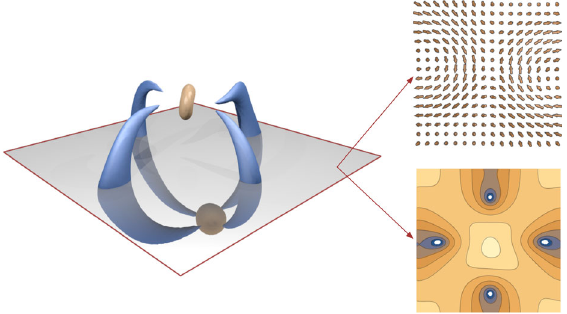
FIG. 4. Umbilic lines in a toron. (a) Simulation results showing point defects and characteristic umbilic loop in a toron. The umbilic loop is transverse and has zero self-linking number. The point defects have opposite charge; due to lattice effects the simulation does not resolve the umbilic lines connecting them, though they are clear in the topology of the eigenvector field. (b) Diagram illustrating the umbilic structure of the toron in S 3 when the boundary of the cell is collapsed to a point. Note that the umbilic loops connecting the point defects each have strength s ¼ 2 , for a total of 4, as required by Eq. (20). (c) Simulation results showing director field for the toron. (d) Contour plot showing the value of j Δ j . (e) Eigenvector field of Π . Note that the umbilic loop is generic and has a monstar